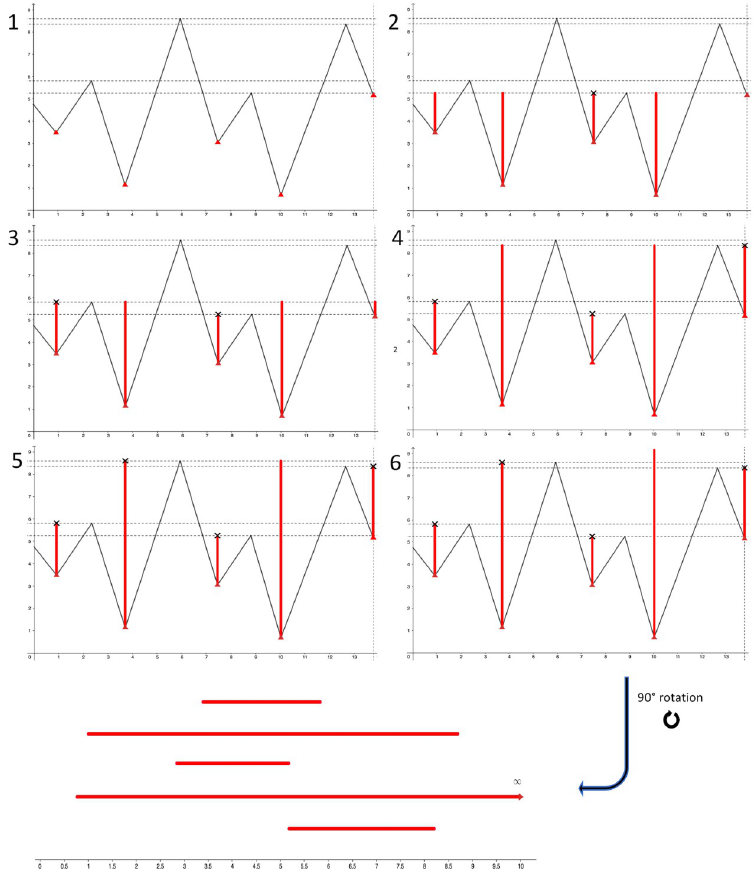
Fig 5. Construction of a persistence barcode. 1: Mark all the local extrema except for the first maximum. The minima are marked by red triangles, the maxima by horizontal lines. 2: Grow bars until the first local maximum. The third bar stops growing. 3: At the second local maximum, the first bar stops growing. 4: At the third local maximum, the fifth bar stops growing. 5: At the fourth local maximum, the second bar stops growing. 6: The fourth bar grows to infinity. Bottom: Horizontal representation of the persistence